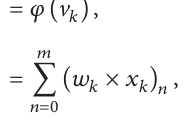
Table 1: Boundary scale for validation and evaluation criteria. Validation/evaluation boundary and scale